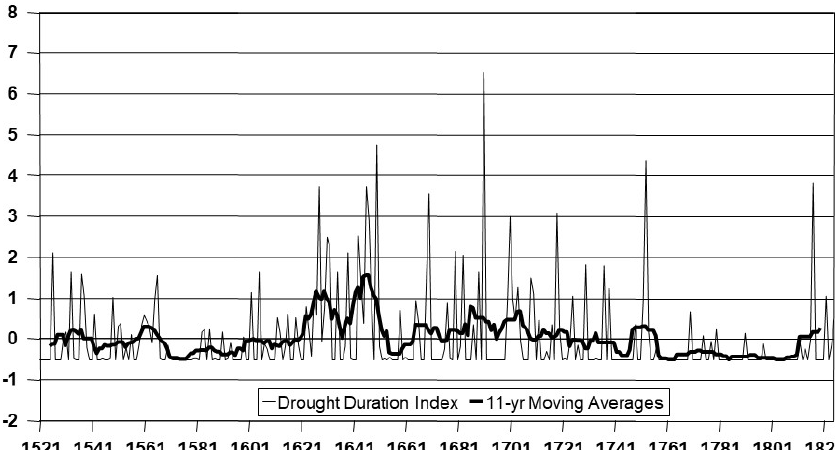
Figure 5. Drought duration index. Standardised values. City of Barcelona